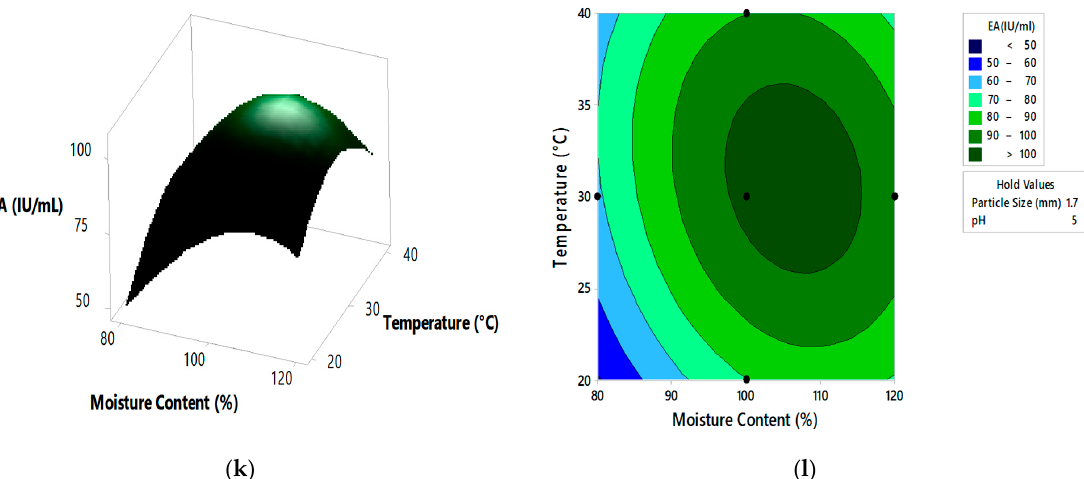
Figure 4. The 3D surface plots and 2D contour plots indicating relative effect for pectinase activ- ity ( a , b ) substrate particle size and initial pH, ( c , d ) substrate particle size and moisture content, ( e , f ) substrate particle size and incubation temperature, ( g , h ) initial pH and moisture content, ( i , j ) ini- tial pH and incubation temperature, and ( k , l ) moisture content and incubation